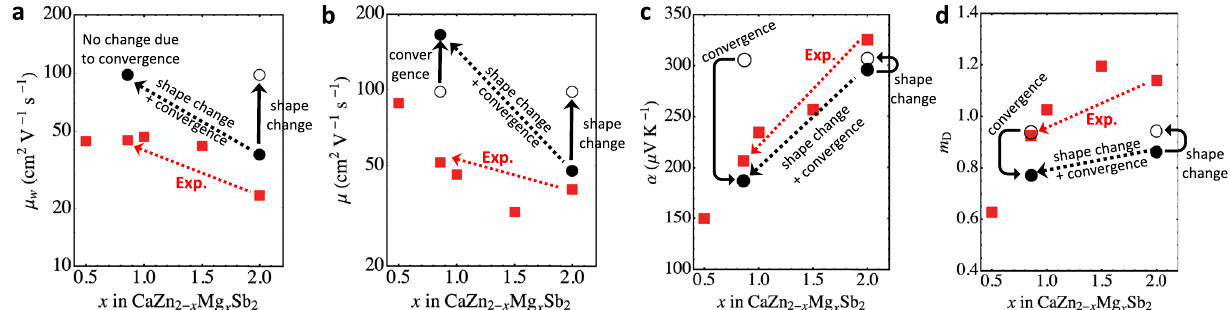
Fig. 3 Computational explanation of the experimental trends with alloy composition. a Weighted mobility, ( b ) mobility, ( c ) the Seebeck coef fi cient, and ( d ) the DOS effective mass. The temperature is 600 K. The experimental data points from ref. 37 are red squares. The calculated values are black circles. The two solid black circles correspond to CaMg 2 Sb 2 at x = 2, and the band-converged CaZnMgSb 2 , which we place at x = 0.86 (the experimental composition of band convergence). The open circle is CaZnMgSb 2 with 0.1 eV offset between the bands, which we place at both x = 2 and x = 0.86. The computational values track the experimental trends in two steps. First, the change from CaMg 2 Sb 2 to the offset CaZnMgSb 2 is purely attributable to changes in band shapes. Then, the change from the offset CaZnMgSb 2 to the band-converged CaZnMgSb 2 is purely attributable to band convergence. Quantitative discrepancies between calculation and experiment are largely attributable to grain boundary scattering and disorder scattering; See Supplementary Fig.